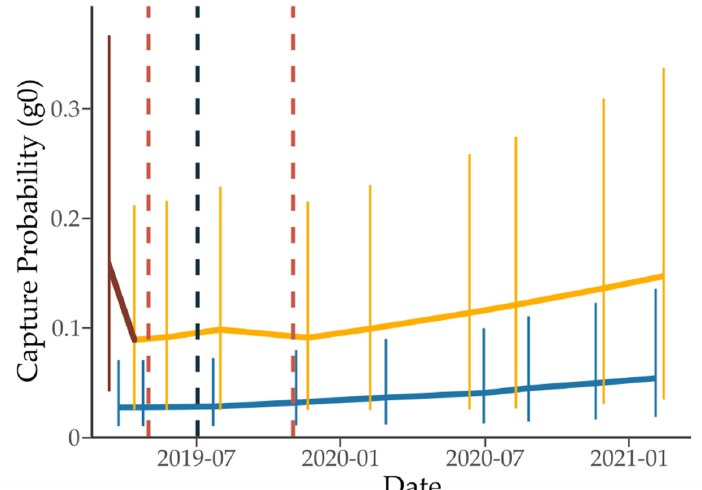
Figure 4. Capture probability (g0) estimates at the 1080-to-zero (lighter orange) and standard treat- ment (darker blue) sites. Error bars indicate 95% lower and upper confidence intervals. The darker brown colour indicates the different trapping method used for the first 1080-to-zero monitoring session. Vertical dashed lines indicate the toxic application at each site (lighter red for 1080-to-zero, darker blue for